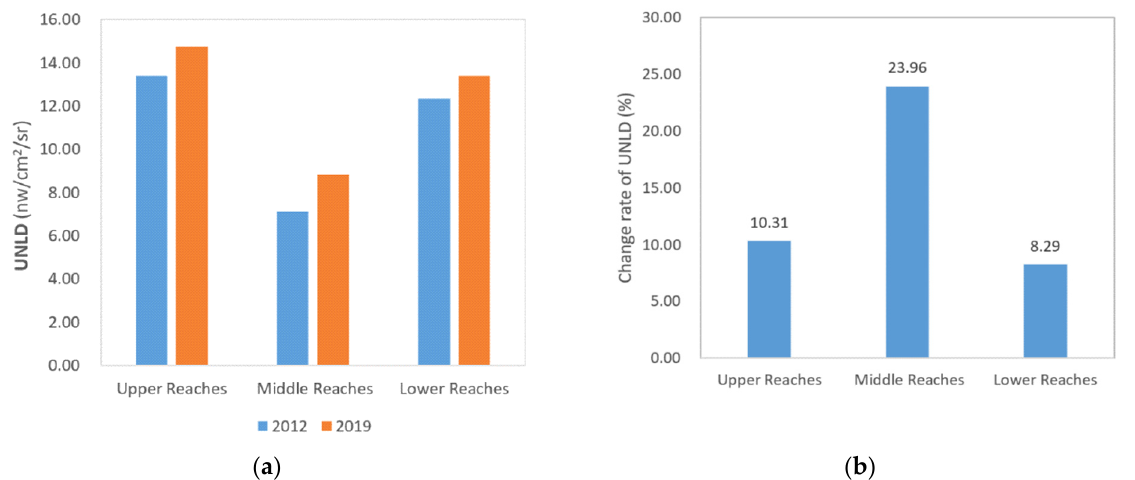
Figure 12. Urban night-time light density (UNLD) and its change rates: ( a ) UNLD for 2012 and 2019; ( b ) change rates.